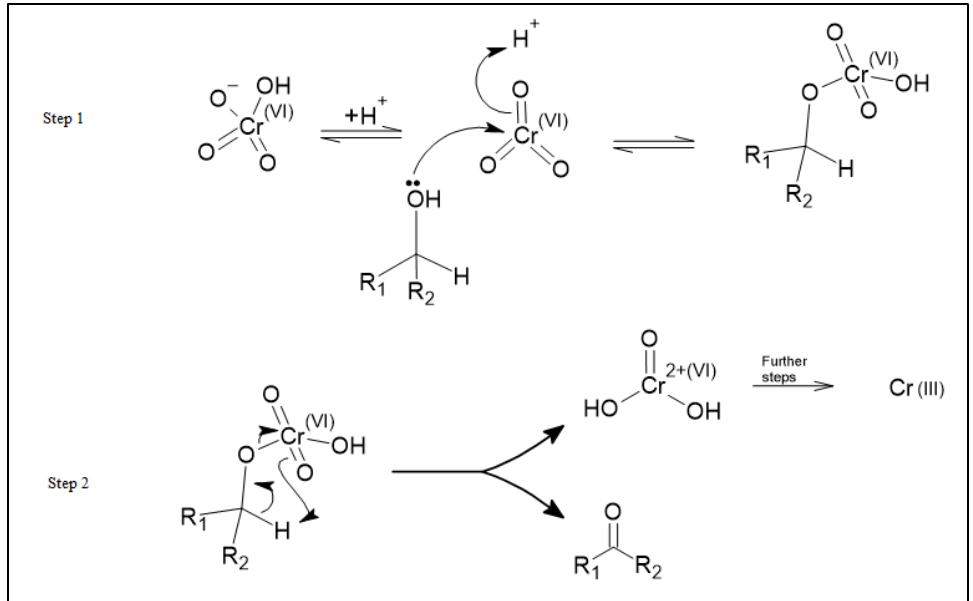
Figure 8. The Jones Oxidation reaction mechanism sourced from Organic Chemistry 2 nd Edition by Clayden et al. Mechanism found on page 544.